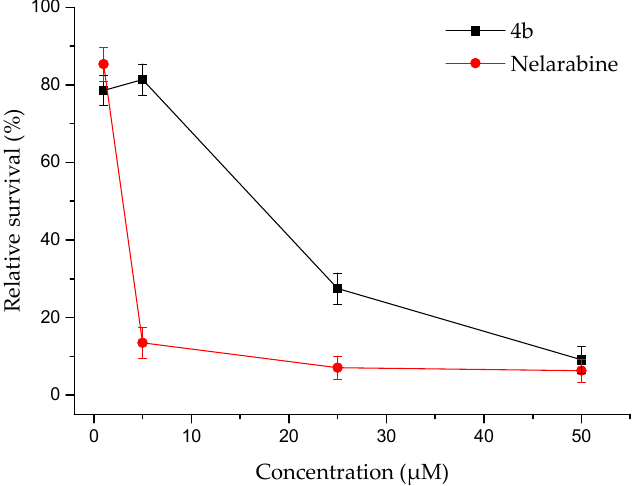
Figure 7. Dependence of U937 cell survival on the concentration of Nelarabine and 4b Figure 7 . Dependence of U937 cell survival on the concentration of Nelarabine and 4b .